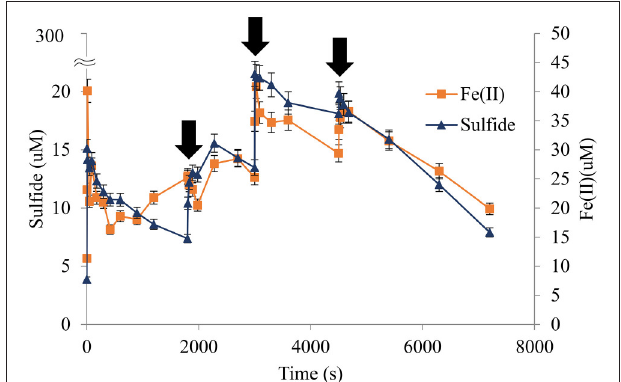
FIGURE 9 | Sulfide spiked into sediments correlated with brief reappearances of Fe(II). Multiple aliquots of sulfide were added to sediments in the presence of oxygen. Sulfide was consumed rapidly in all cases with the nominal concentration of 300 × 10 − 6 M at each spike not detected. Dissolved Fe(II) increased slightly corresponding with each addition but was reoxidized on a similar timescale to that of the initiating pulse ( indicates time of sulfide addition, pH 8.25, 1.00 wt% marsh mud shown).